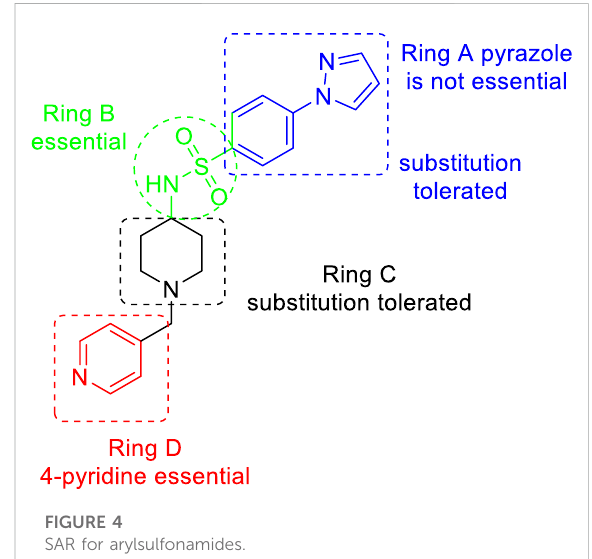
FIGURE 4 SAR for